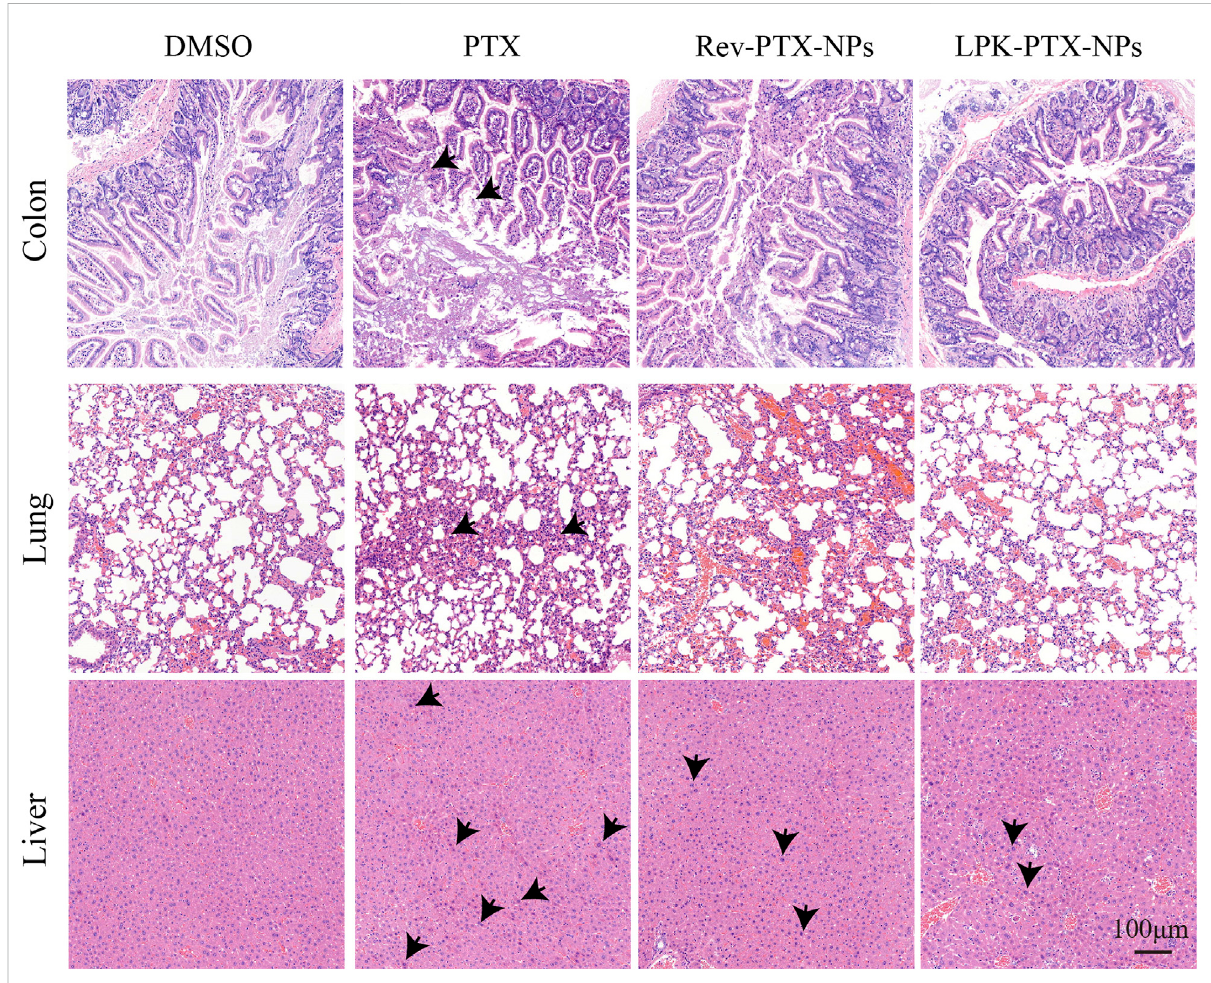
FIGURE 7 HE staining of colon, lung and liver in nude mice with different treatments. Colon crypt destruction was observed in PTX group but not in LPK- PTX NPs group. Apoptotic cells in liver and broken fi bers in lungs were greatly reduced or absent in LPK-PTX NPs treated mice compared to PTX treated mice. The damages were indicated by arrows. Scale bar, 100 μ